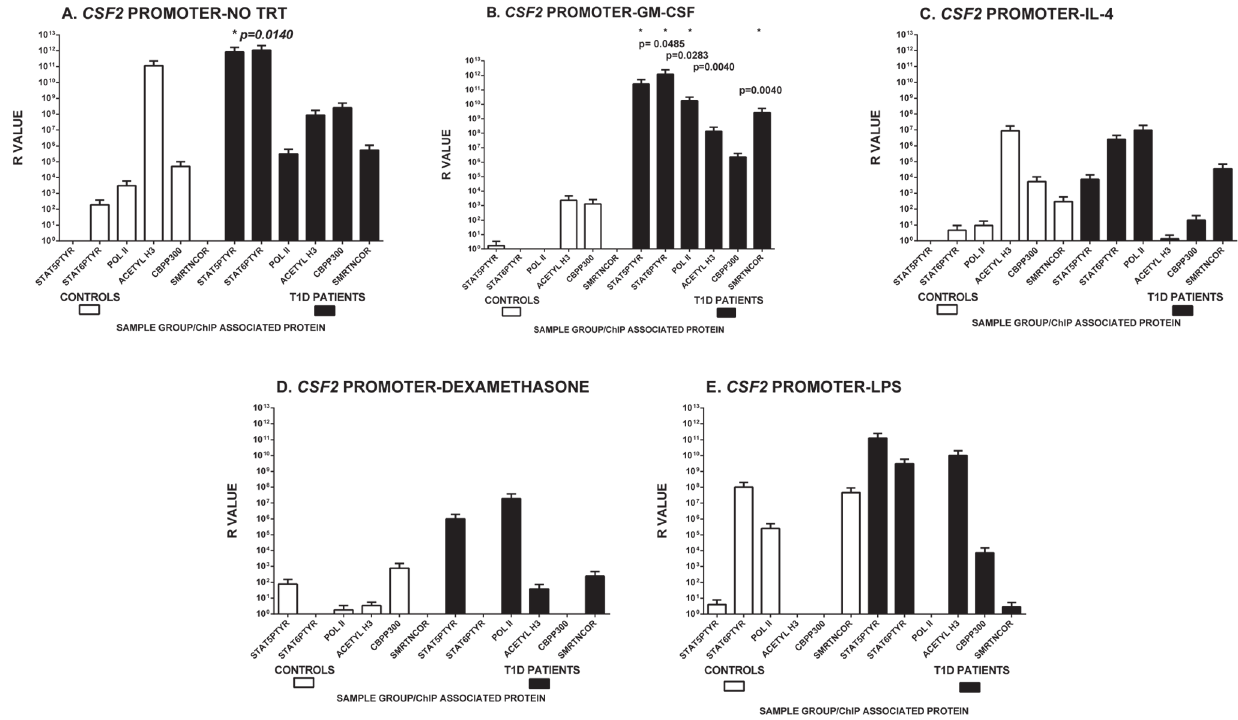
Figure 4. Multiplex ChIP analysis of Protein Binding, Epigenetic Modification, and Transcription at the CSF2 promoter region. Peripheral blood monocytes were isolated and incubated at 37 u C/5%CO 2 for 2 hr in ( A ) media alone (0) or continuously supplemented with ( B ) 5.6 nM GM-CSF (GM-CSF), ( C ) 500 U/ml IL-4 (IL4), ( D ) 100 m M dexamethasone (DEX), or ( E ) 1 ng/ml endotoxin (LPS). Time of incubation was set to allow the negative (DEX) and positive (LPS) control supplements adequate time to affect the cells. The cells were washed and extracted for